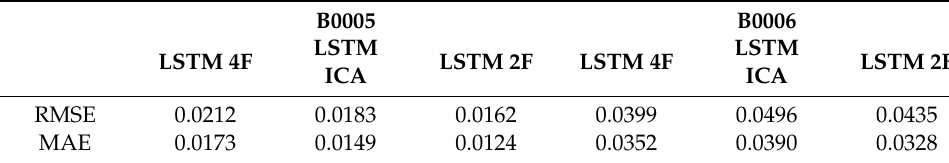
Table 4. The loss rate of 5# and 6#.